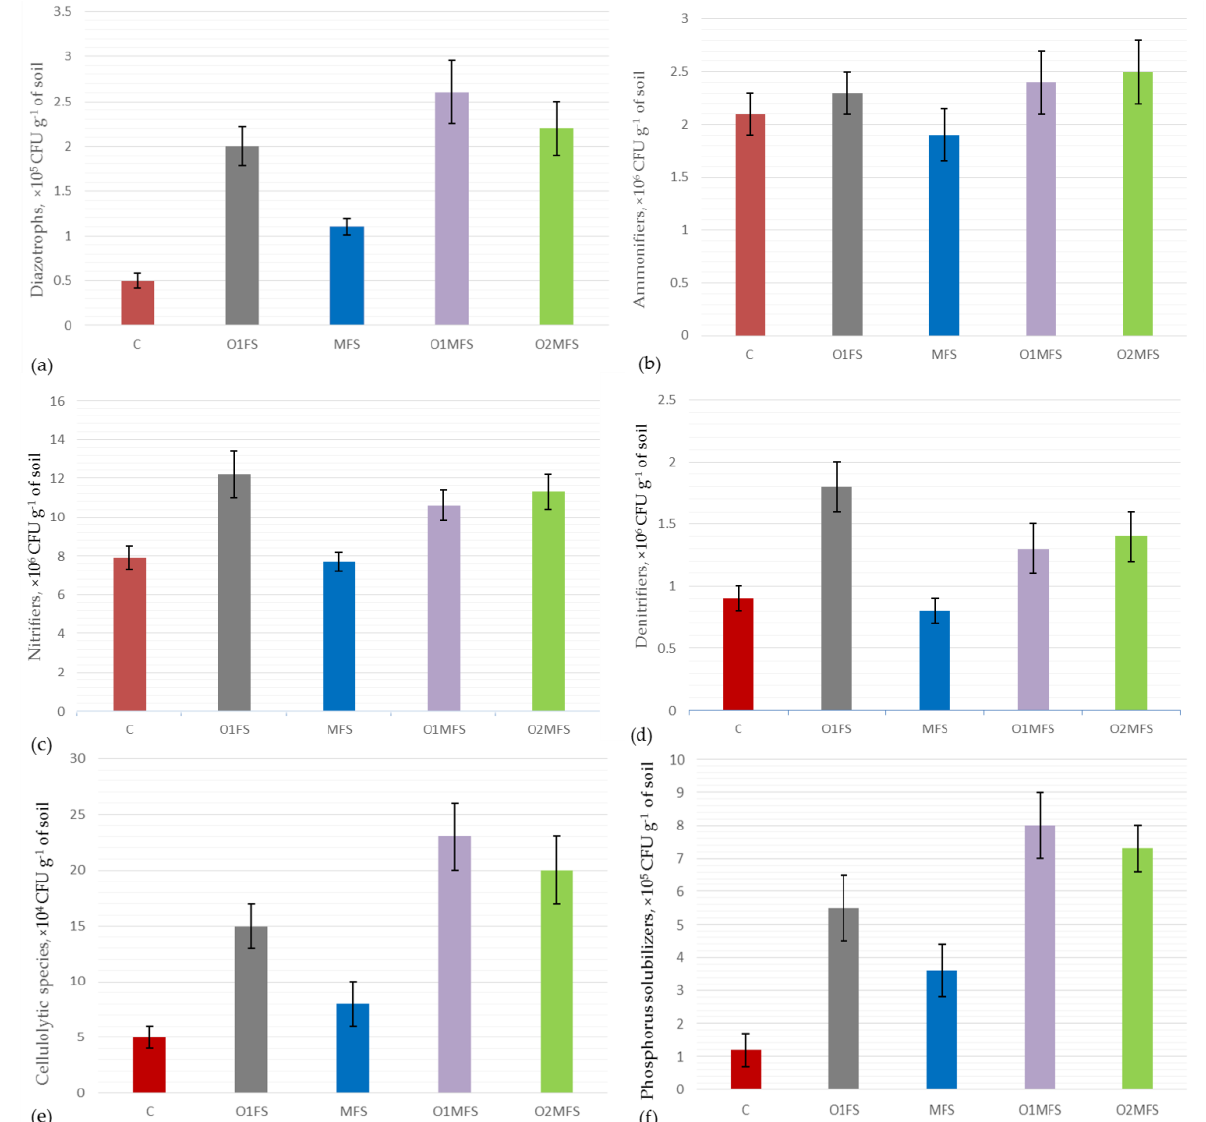
Figure 4. Number of physiological groups of soil microorganisms in sod-podzolic soil depending on fertilization system, ( p < 0.05), average from 2019–2021: ( a )-anaerobic nitrogen-fixing bacte- ria; ( b )-organotrophic bacteria; ( c )-soil nitrifiers; ( d )-denitrifiers; ( e )-cellulolytic microorganisms; ( f )-phosphorus-solubilizing microorganisms. Experiment variants: without fertilizer (C); organic fertilization system, manure (O1FS); mineral fertilization system, NPK (MFS); organic-mineral fertil- ization system, manure + NPK (O1MFS); and organic-mineral fertilization system, siderate + NPK